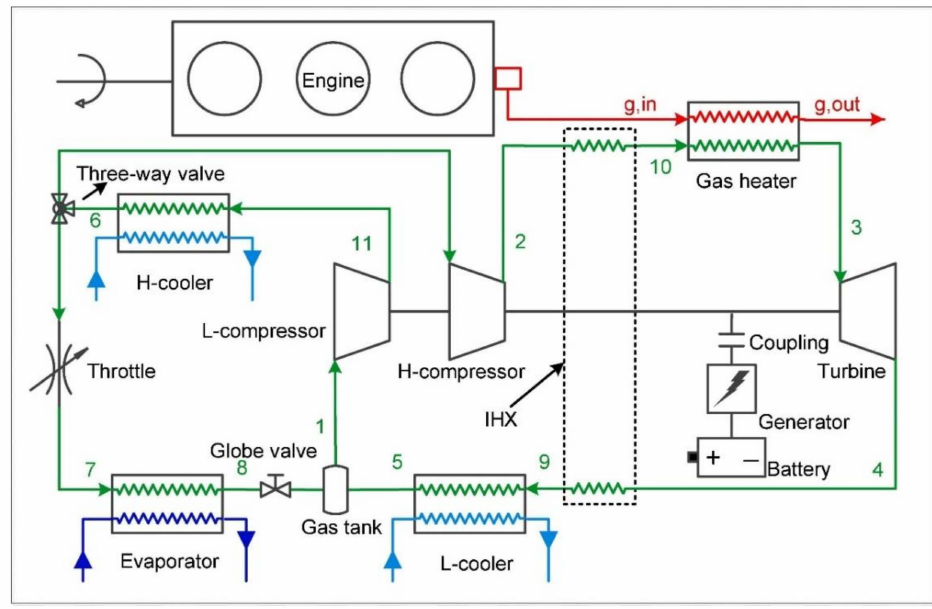
Figure 24. Structure diagram of MM-CRPC. Reprinted from ref. [73], Copyright (2020), with permis- sion from